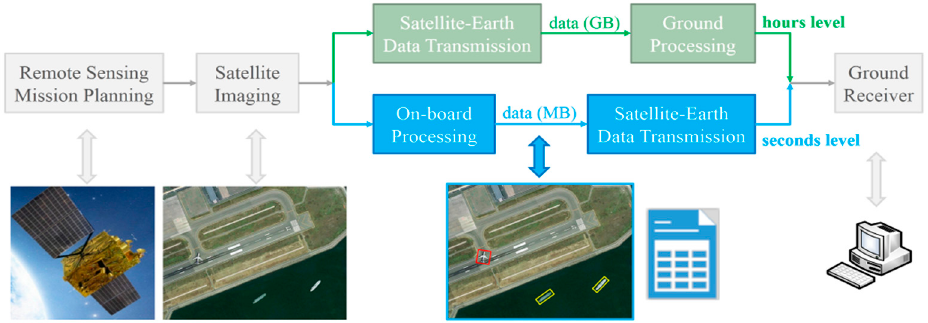
Figure 1. Comparison of remote sensing methods between ground processing and on-orbit pro- cessing.